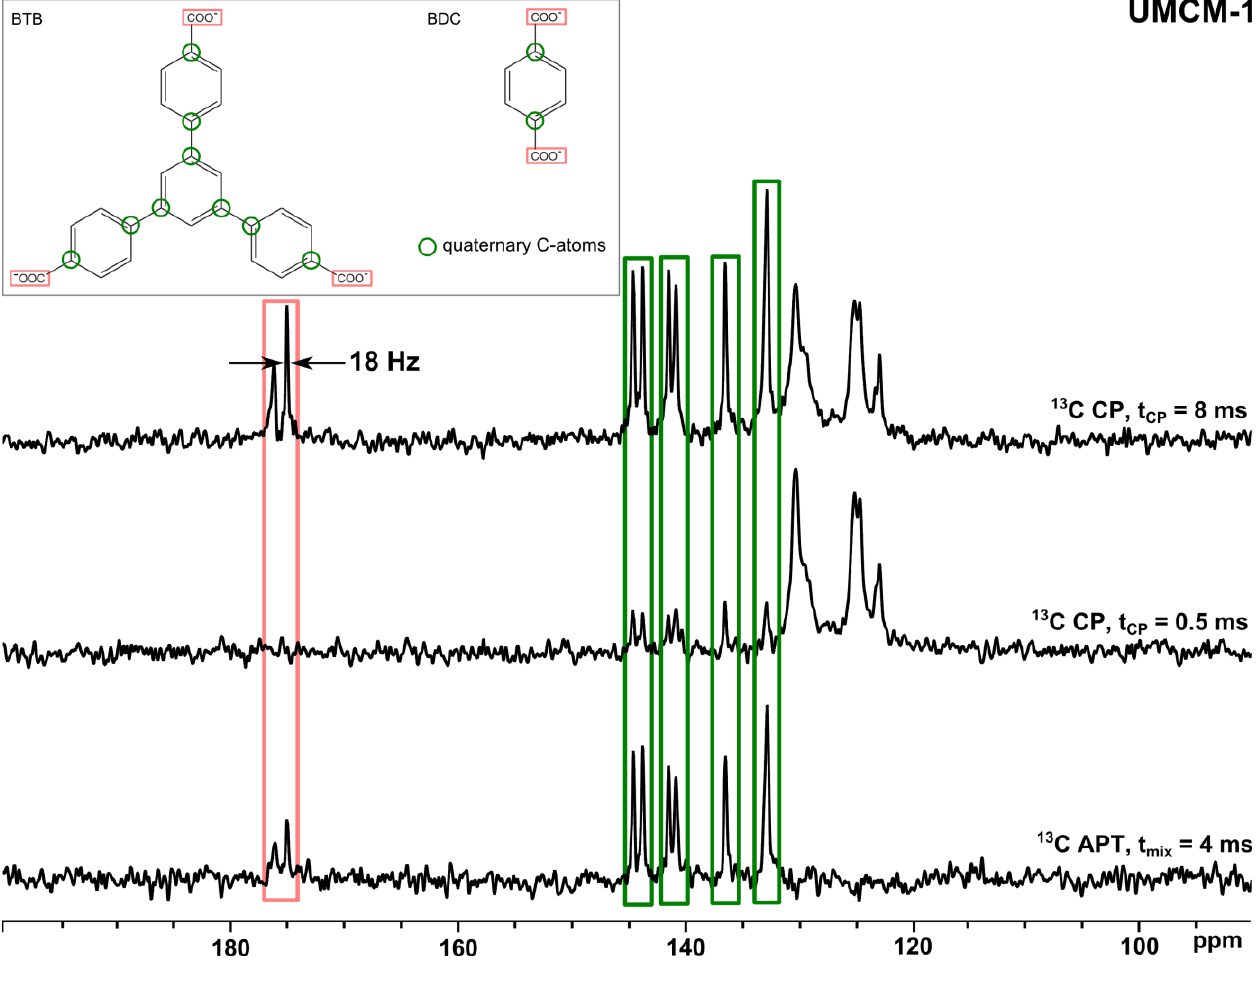
Figure 3. 13 C{ 1 H} CP MAS NMR spectra (upper and middle spectrum) and solid-state attached proton test (APT) spectrum (lower spectrum) of activated